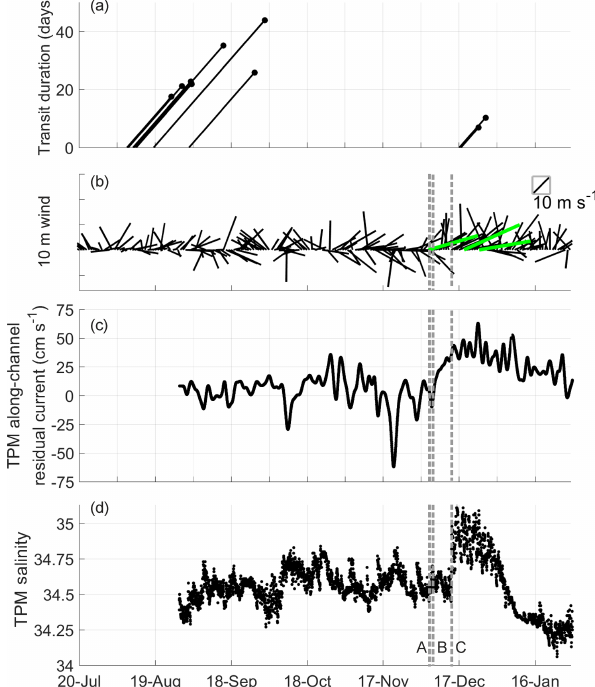
Figure 5. (a) Transit times and durations of 70m drifters between the shelf edge (200m isobath) and a meridional line at 8 ◦ W signify- ing arrival at the inner shelf. Lines commence as each drifter crosses the shelf edge and terminate when it passes 8 ◦ W. (b) Vector plot of 10m wind speed and direction on the Malin Shelf (56 ◦ N, 7 ◦ W) derived from the ECMWF ERA-Interim product. Instances of west- erly storm events (daily mean westerly wind >18m s − 1 ) are shown in green. (c) Low-pass-filtered along-channel currents at the TPM and (d) 20m salinity at the TPM. Grey dashed lines denote the fol- lowing events. A: first storm event (storm Xaver). B: onset of strong poleward currents at the TPM. C: beginning of a high-salinity pulse (HSP) at the